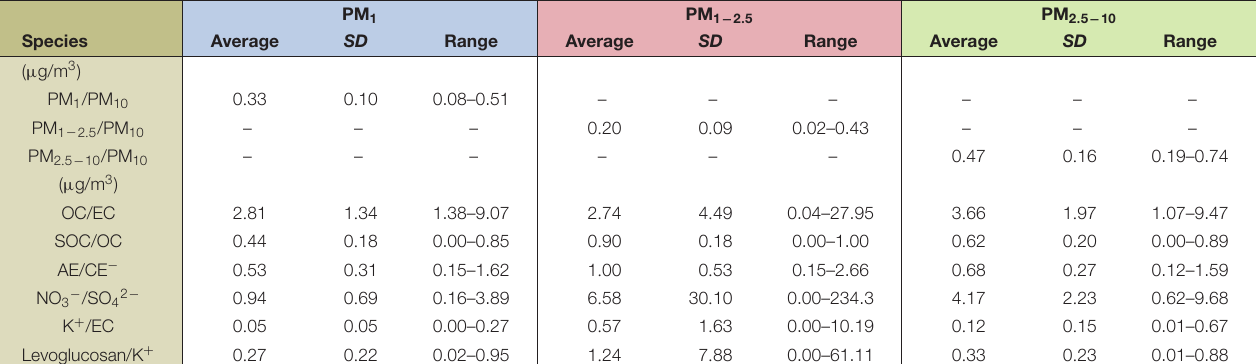
TABLE 2 | Statistical summary of the fraction-wise PM’s characteristic